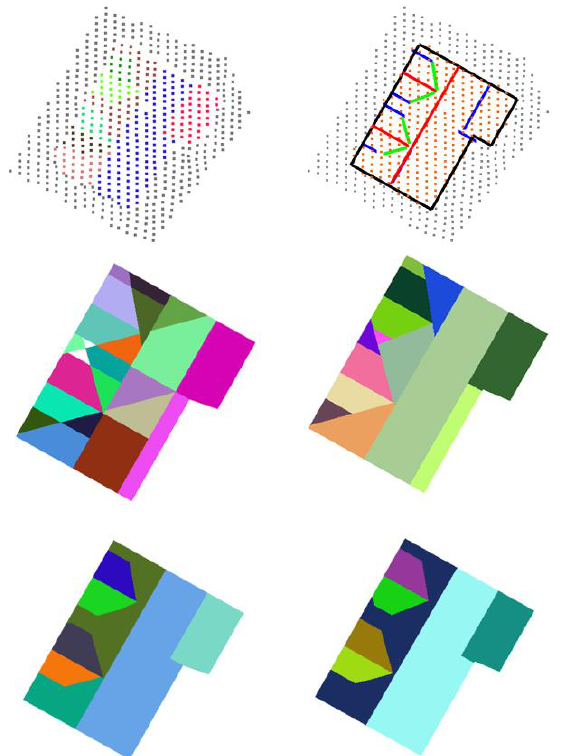
Figure 7. Left column: The result of the segmentation using a RANSAC plane extraction method and the BSP without considering building knowledge before and after the merging process. Right column: The result of the line extraction based on building knowledge and the building knowledge considering BSP before and after the merging process.